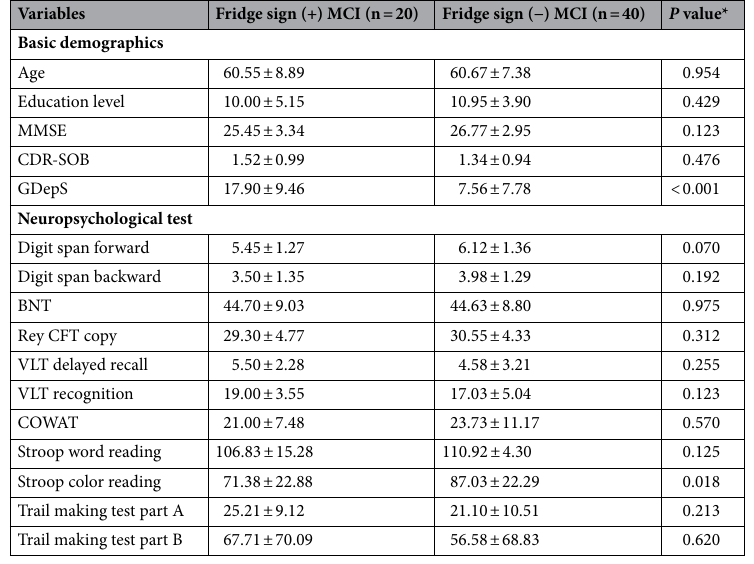
Table 2. Comparison of neuropsychological test results between ‘fridge sign’-positive MCI patients and ‘fridge sign’-negative MCI patients. Values are given as the mean ± standard deviation. MCI mild cognitive